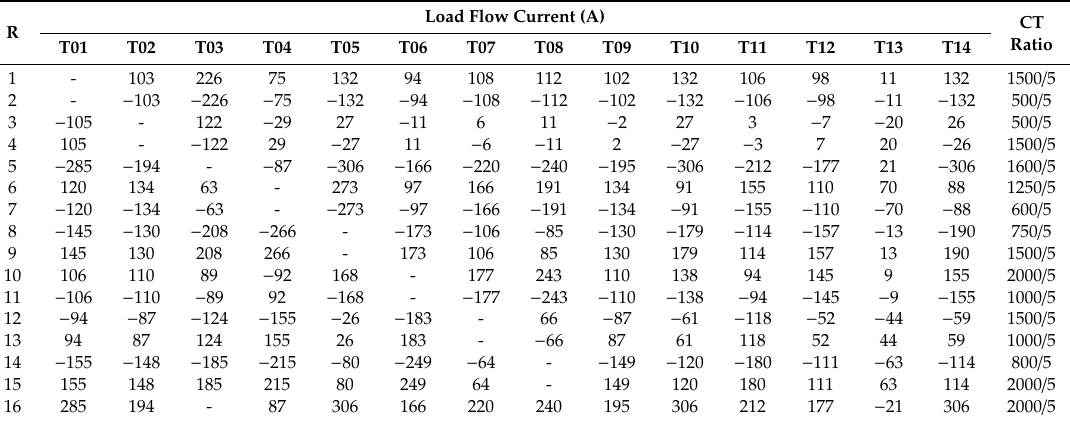
Table 7. Load flow analysis for normal operation.